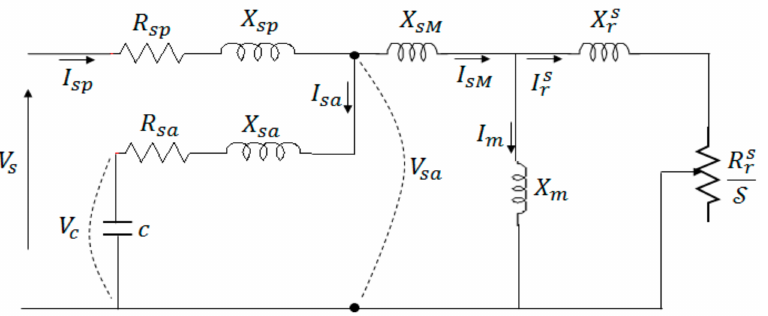
Figure 2. An equivalent per-phase steady-state circuit of an induction motor with auxiliary winding. In the figure, X s and R s denote the rotor leakage reactance and resistance, respectively, r r and referred to the stator; R sa and X sa denote the auxiliary stator winding resistance and leakage reactance, respectively; X m denotes the magnetizing reactance; S denotes the slip; V s denotes the supply voltage; V c denotes the voltage across the capacitor c ; V sa denotes the voltage across the RLC branch that represents the auxiliary winding; I m denotes the magnetizing current; I s denotes the rotor current referred to the stator; I sM denotes the r current flowing through the mutual reactance; I sa denotes the current flowing through the capacitive auxiliary winding; and I sp denotes main (primary) stator current.